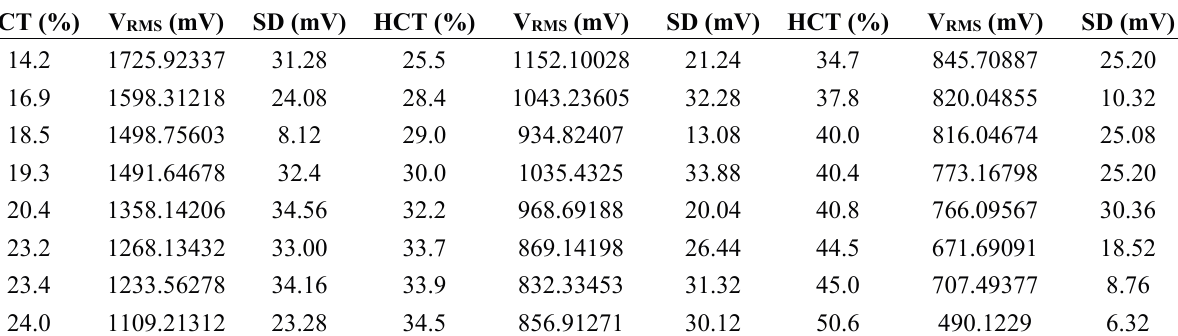
Table 2. Device validation with whole blood